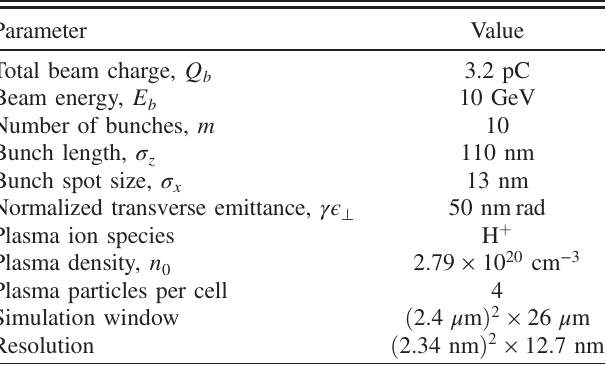
TABLE I. Table of parameters for the simulation shown in Fig. 1. Parameter Value